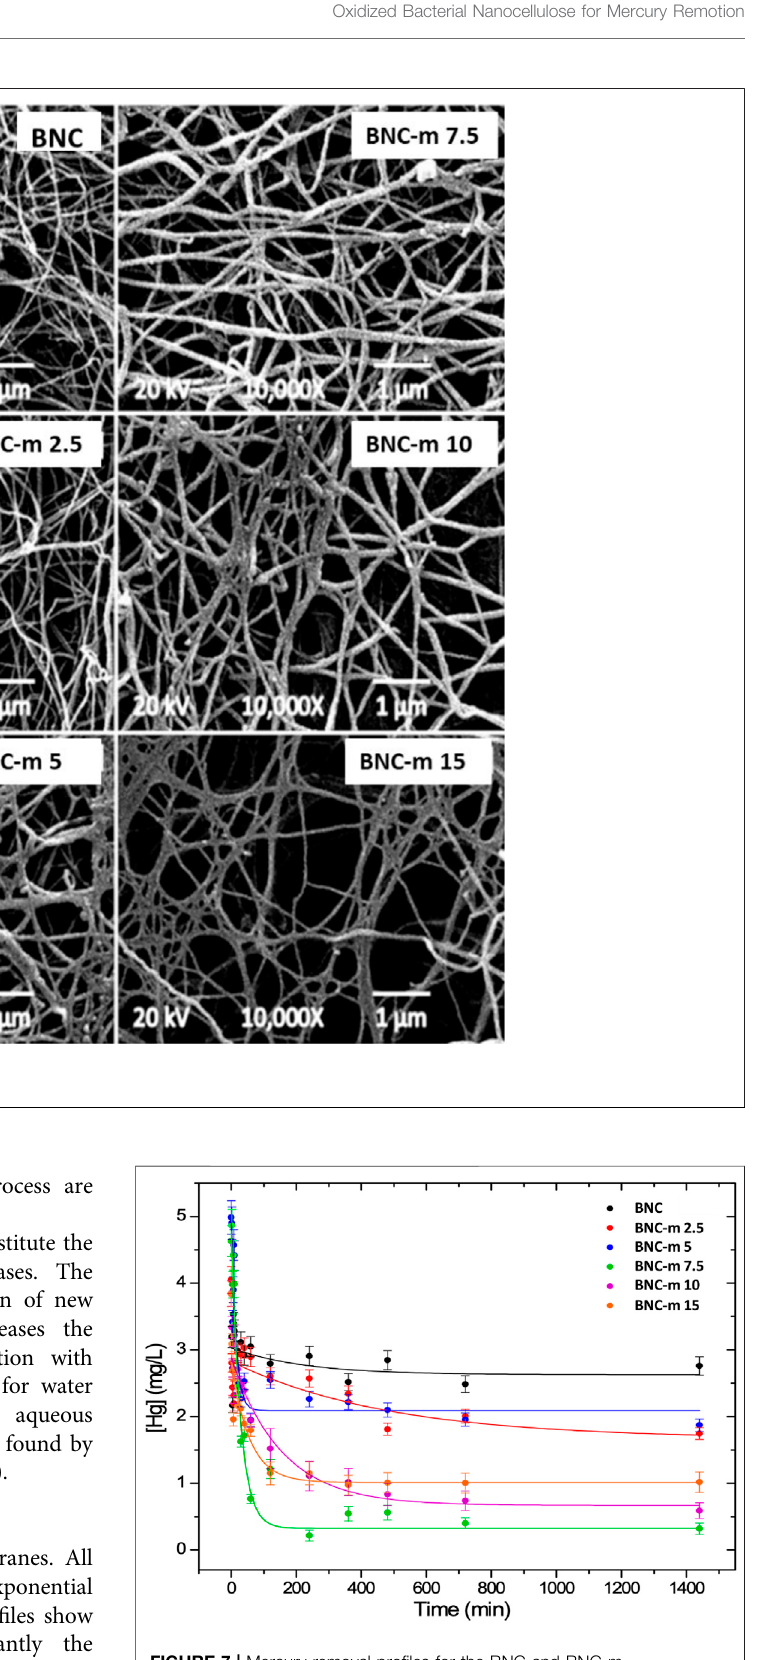
FIGURE 7 | Mercury removal pro fi les for the BNC and BNC-m